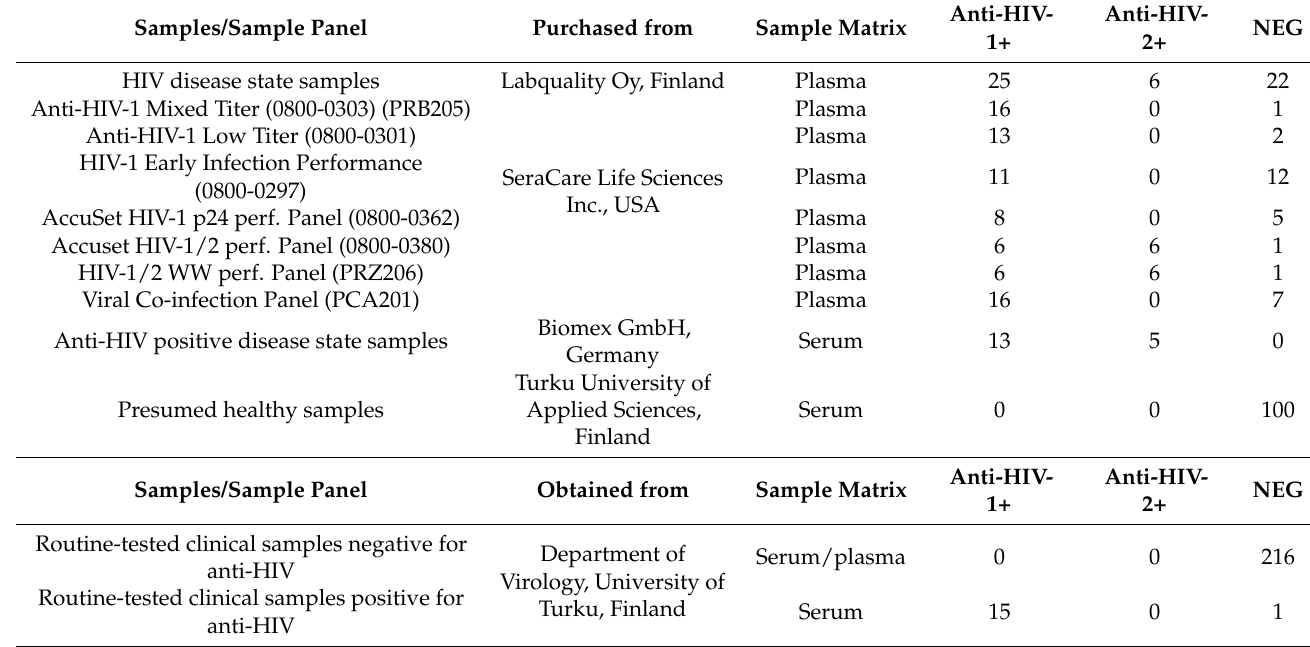
Table 1. Clinical samples used in the evaluation of